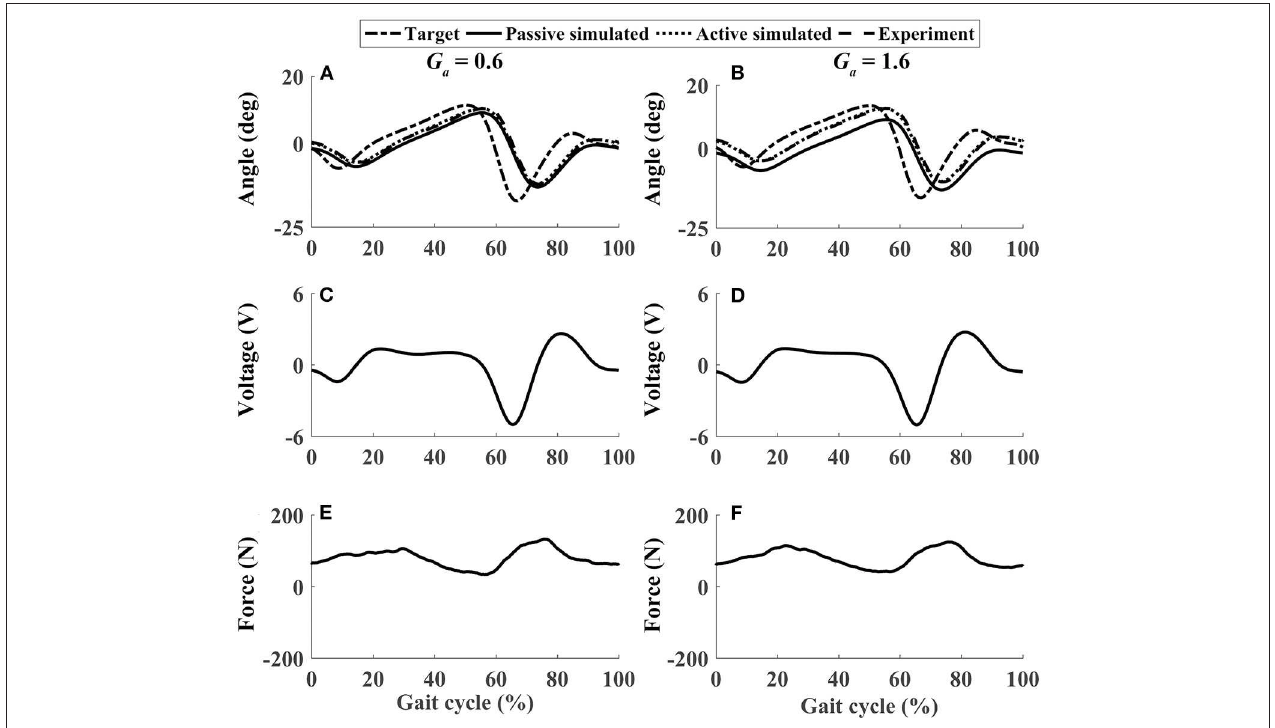
FIGURE 8 | The performance of P1 when he lifted up his foot voluntarily during the whole gait cycle (Case 1). (A,B) Ankle joint trajectories. (C,D) Input voltage. (E,F) Active force.